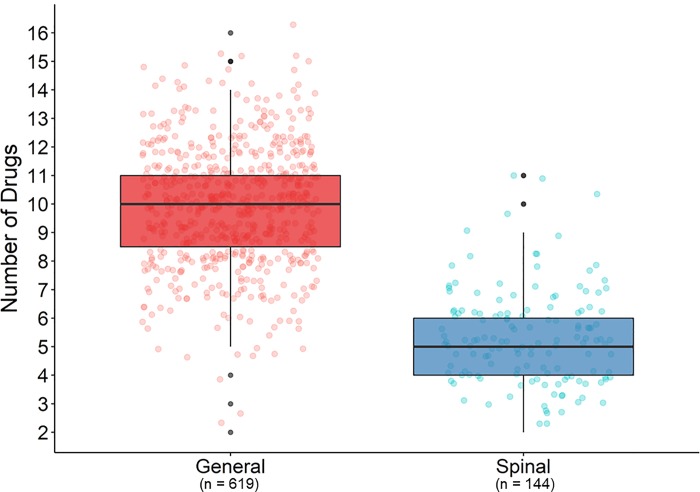
Number of drugs administered by group.Total number of drugs administered for each type of anesthetic. For each group the plot shows all data points, median, Interquartile Range (IQR) and outliers (black circles).